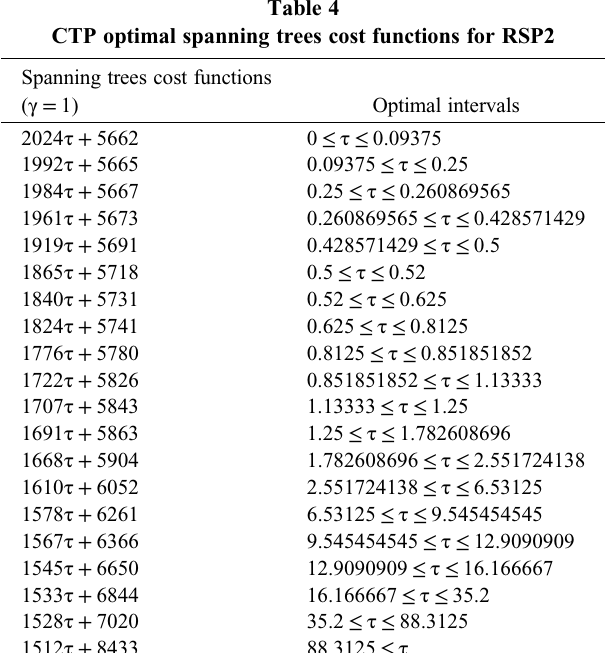
execution time. In Table 4, summary information for the 20